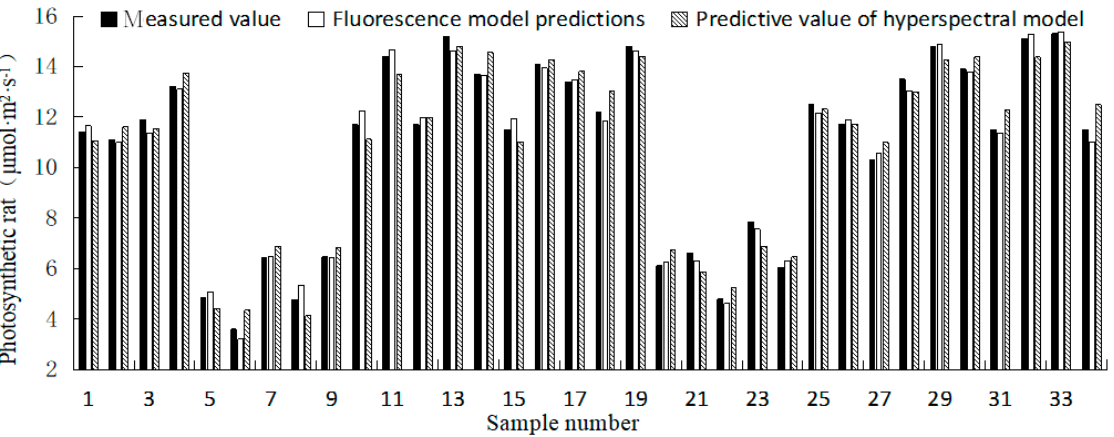
Figure 9. Contrast diagram of the predicted photosynthetic rates obtained from the two models.